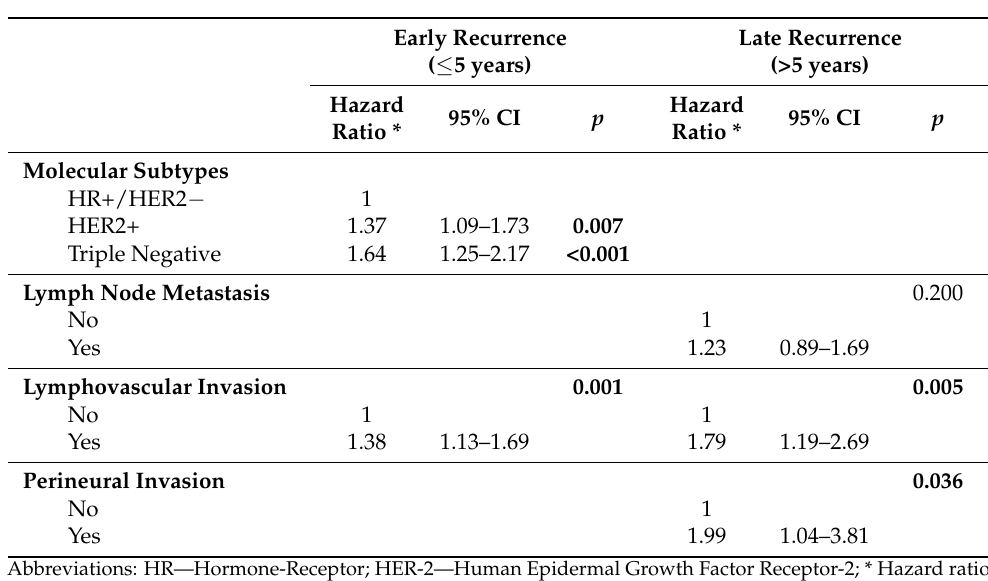
Table 5. Multivariate analysis of disease-free